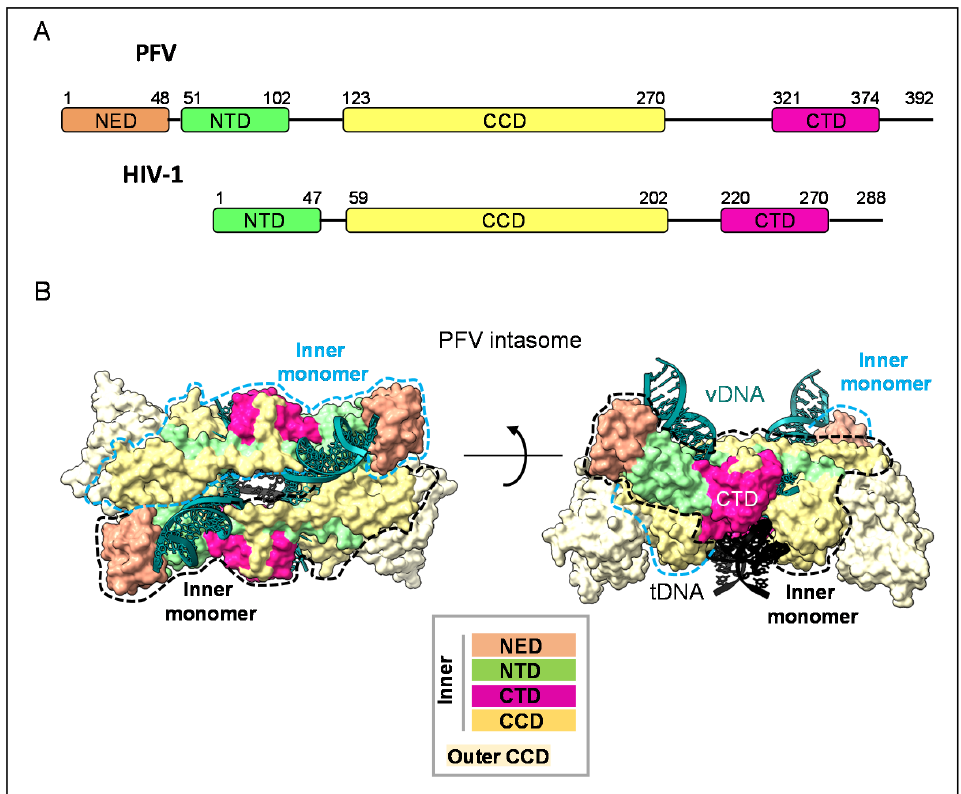
Figure 2. Domain organization of IN and structure of PFV intasome. ( A ). Integrase (IN) domains and interdomains are indicated by boxes and lines, respectively. Starting and ending amino acid residues are indicated above the boxes [30]. PFV integrase (upper representation) has an additional N-terminal extension domain (NED, in orange) that is not present in HIV-1 integrase (lower representation). N-terminal domain (NTD) is in green, the catalytic core domain (CCD) in yellow and C-terminal domain (CTD) in dark pink. This domain organization is conserved among retroviral integrases [2]. ( B ) Surface representation of the crystal structure (PDB: 3OS0, [27]) of PFV strand-transfer complex (STC) viewed along and perpendicular to the two-fold axis. IN is organized as an elongated tetramer along the DNA; the inner IN monomers are organized around vDNA and bring 3 ′ extremities close to tDNA. The two inner monomers are outlined by dashed lines (light blue and black). The vDNA, tDNA and IN domains are indicated and follow the colour code of Figure 2A. Outer monomers are represented only by outer noncatalytic CCD domains, which are coloured in pale yellow.